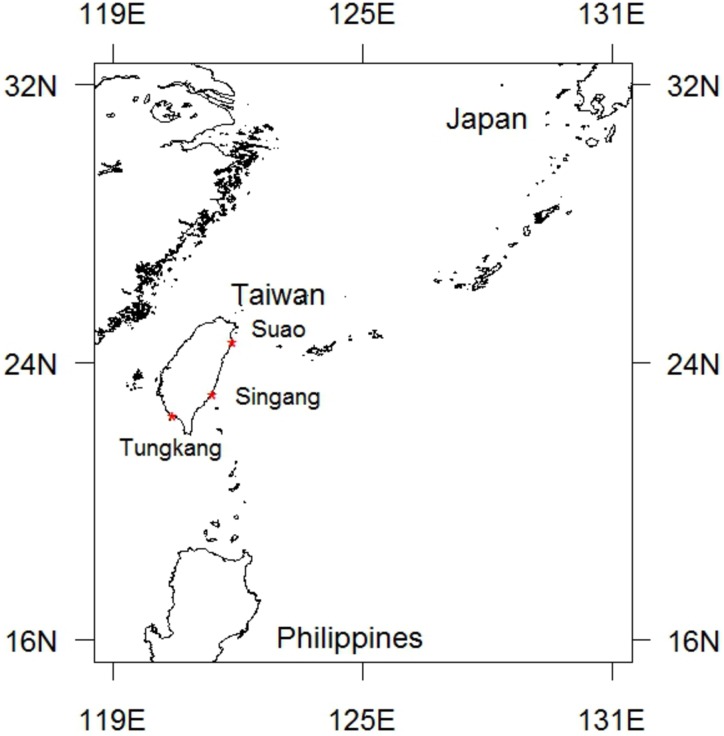
Major PBF landing ports in Taiwan: Suao, Singang, and Tungkang.